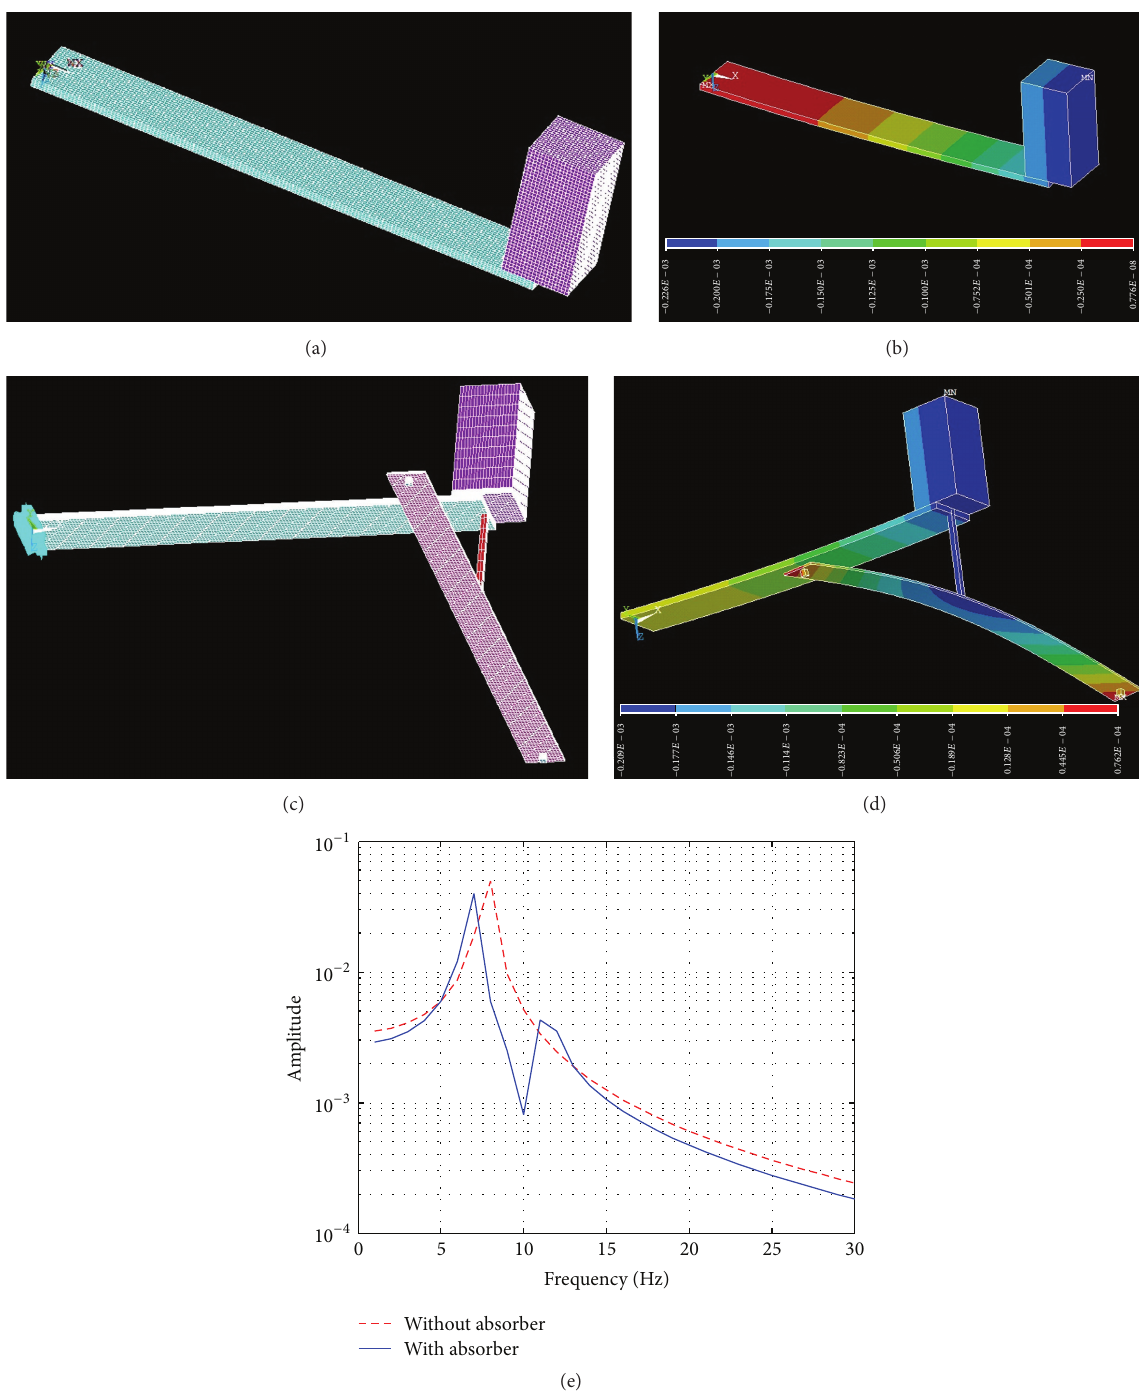
Figure 11: Harmonic analysis of the system: (a) modeling and meshing of the system without absorber, (b) normalized displacement in 𝑧 direction of the system without absorber, (c) modeling and meshing of the system with absorber, (d) normalized displacement in 𝑧 direction of the system with absorber, and (e) spectrum of the response under broadband swept-harmonic